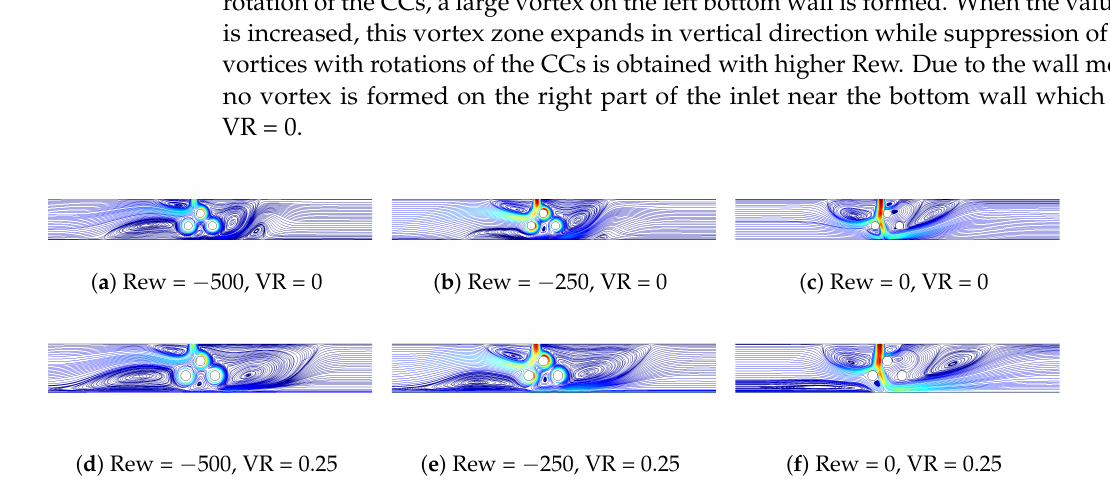
Figure 5. Effects of Rew on streamline variations considering two different velocities of hot wall (Ha = 5, Mx = −